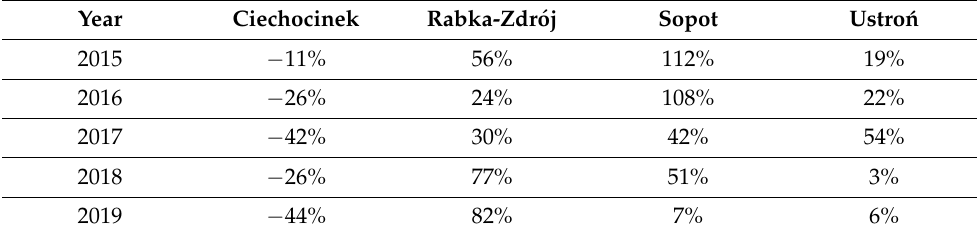
Table 9. Calculated excessive cancer risk for four health resorts in Poland. Year Ciechocinek Rabka-Zdr ó j Sopot